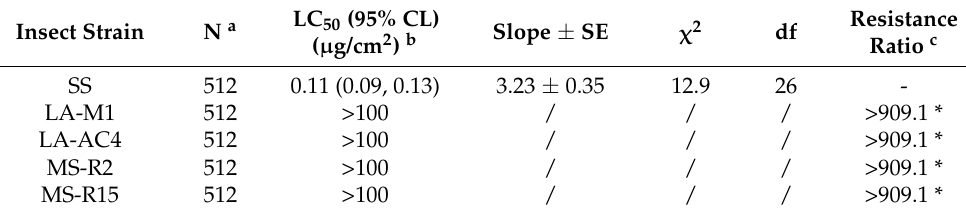
Table 4. Dose-response bioassays of different Helicoverpa zea populations against Vip3Aa39 Bt protein. Insect Strain